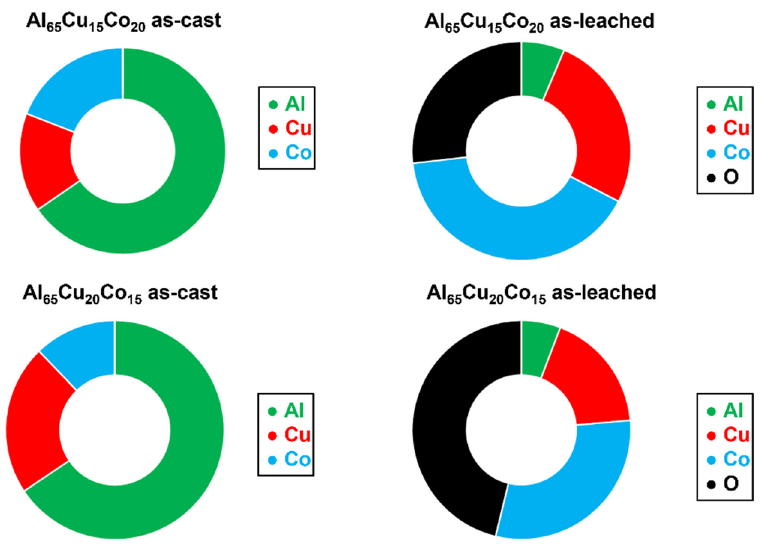
Figure 16. Chemical composition (in at.%) of as-cast and as-leached Al–Cu–Co alloys, plotted from data in reference [100].